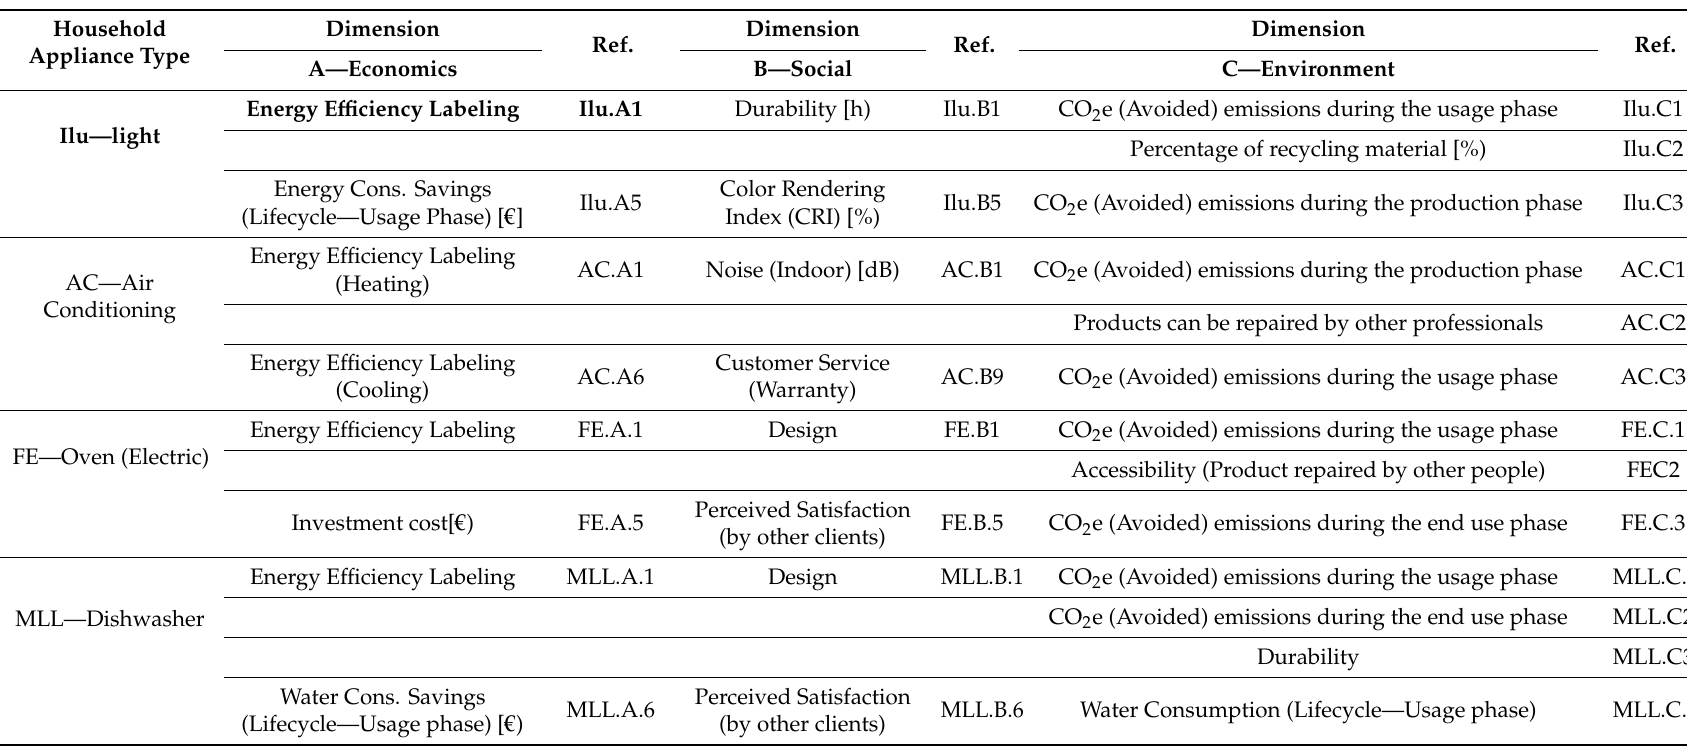
Table 3. Adopted criteria to define problem dimensions according to the household appliance (energy service)